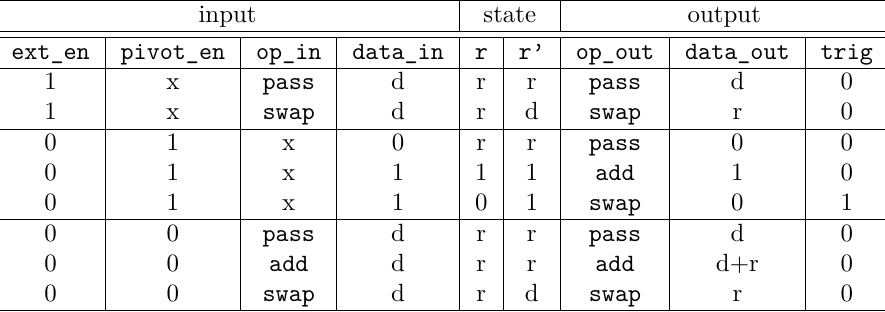
Table 3: The truth table for processor_AB in this work.